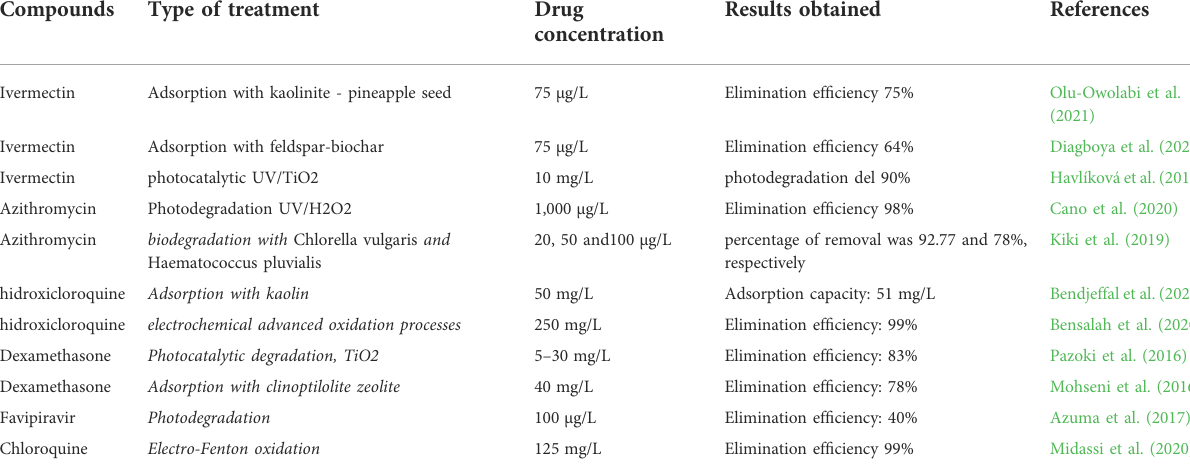
TABLE 4 Reported treatment technologies for the elimination of pharmaceutical compounds used in COVID-19